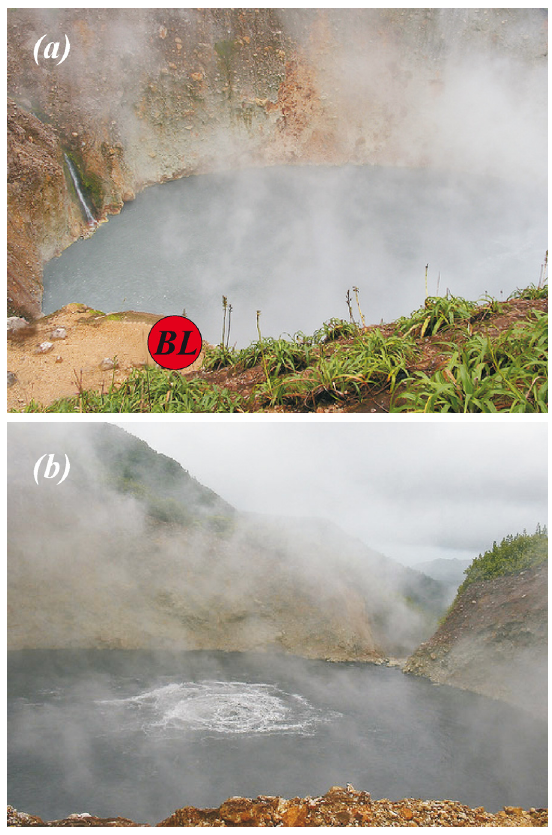
Figure 1. The Boiling Lake: (a) our Multi-GAS measurement site is indicated a BL; (b) vigorous gas bubbling in the lake’s